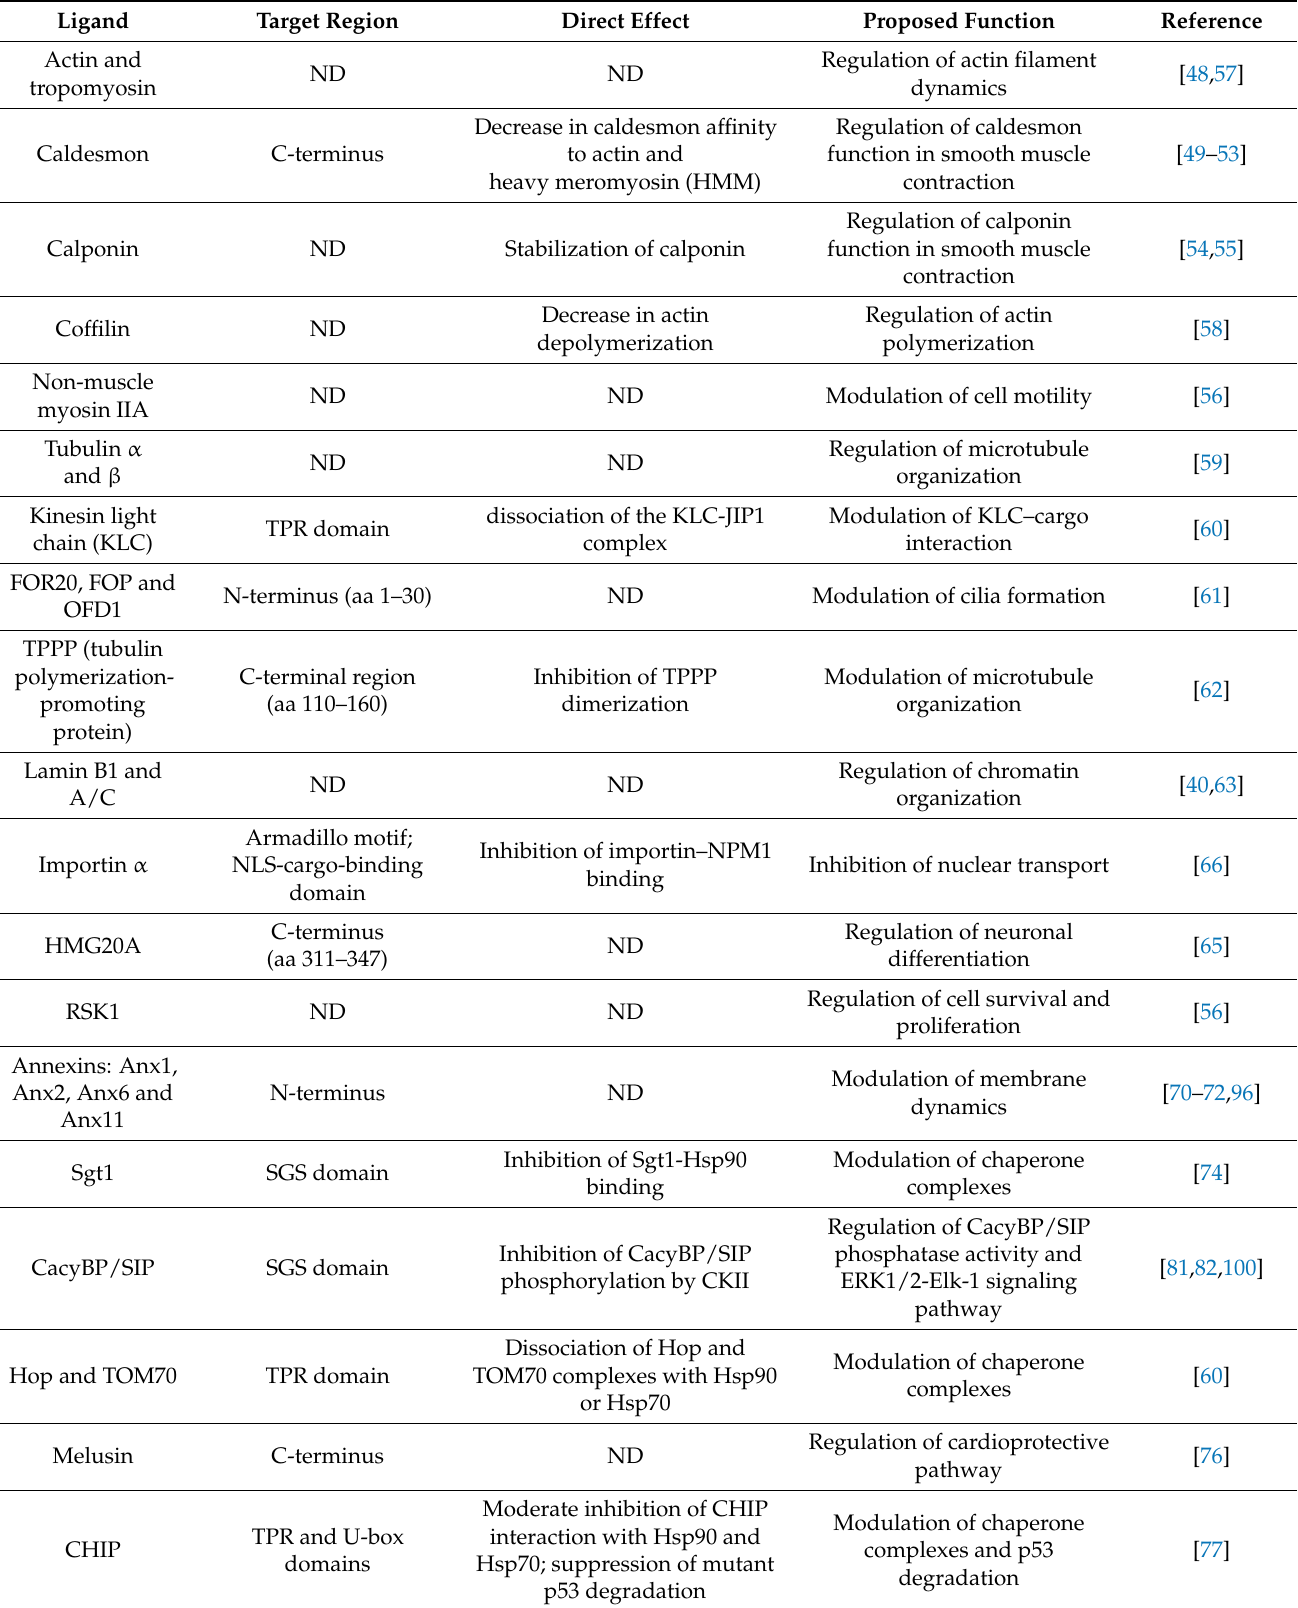
Table 1. Intracellular and extracellular S100A6